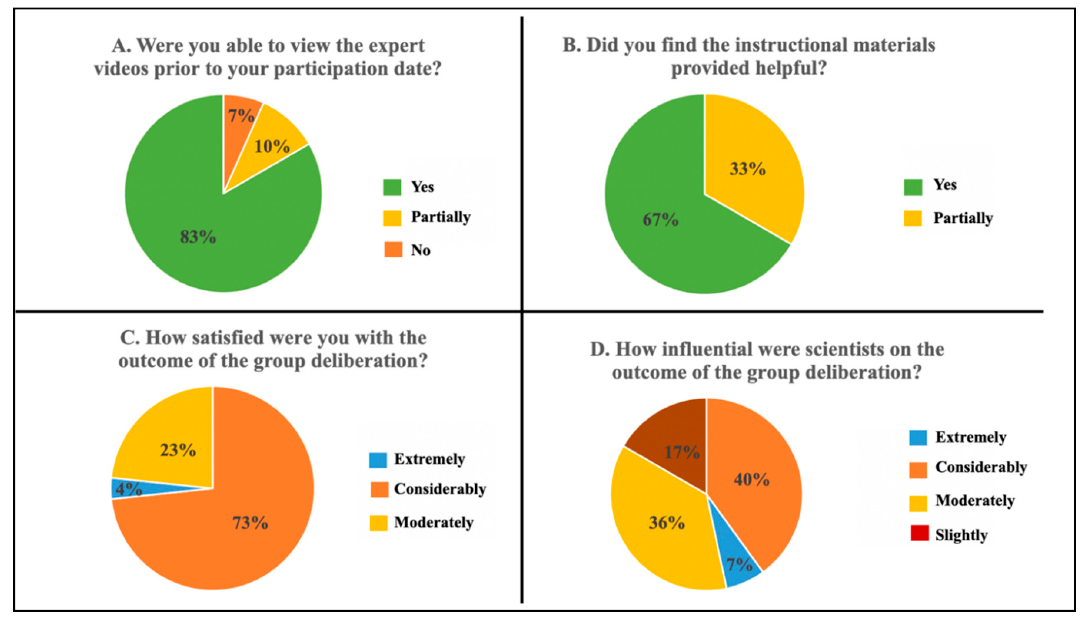
Figure 4. Responses from the evaluation form that participants were asked to complete post-workshop.